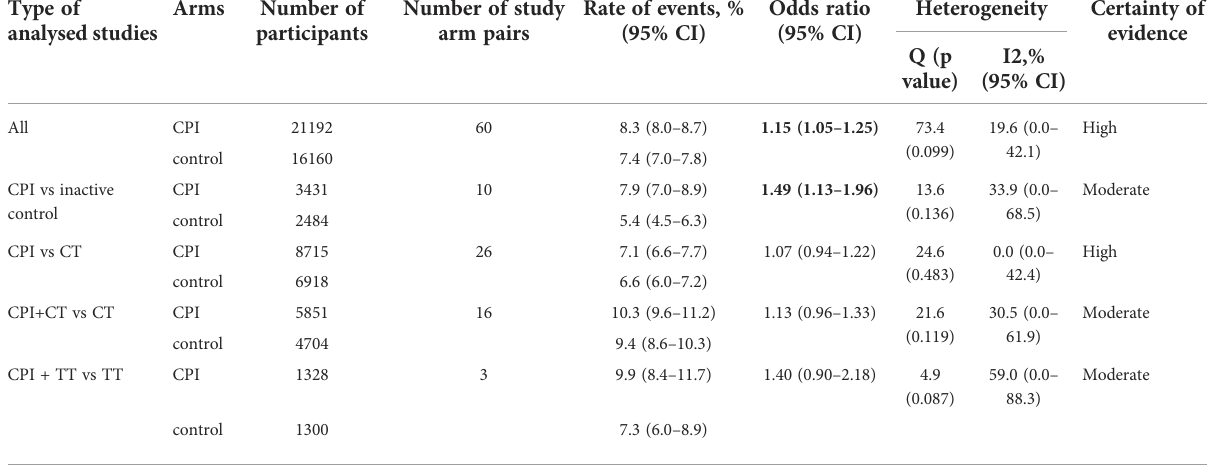
TABLE 1 Risk of all-grade insomnia – summary of